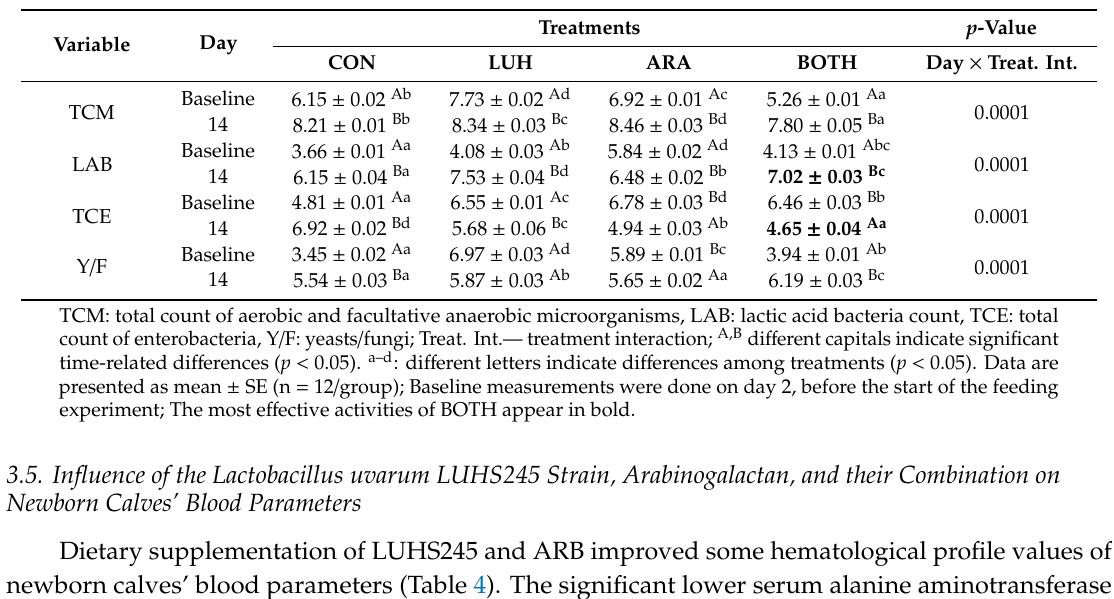
Table 3. Fecal microbiological parameters of calves fed milk replacer only (CON), or supplemented with L. uvarum LUHS245 strain (LUH) or arabinogalactan (ARA) alone, and together